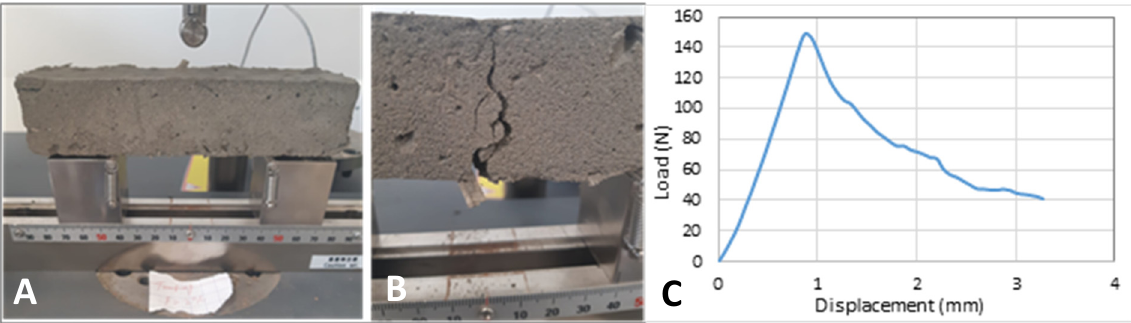
Figure 7. Crude bricks flexural strength test ( A ), brick failure ( B ) and load–deflection curve ( C ).